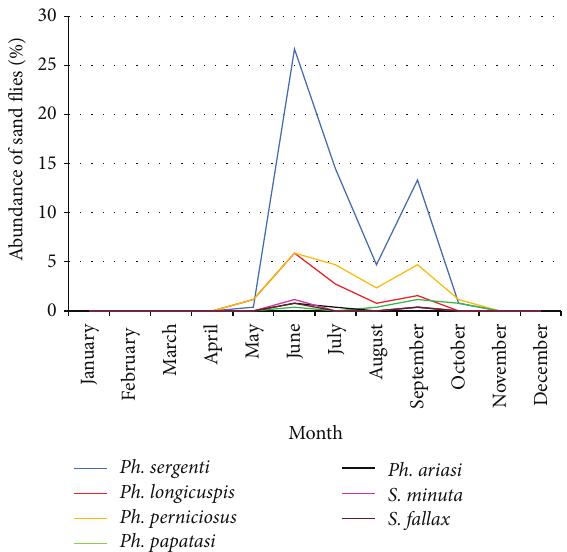
Figure 5: Seasonal distribution of sand flies captured at Bouasseme by adhesive traps in the period from January to December